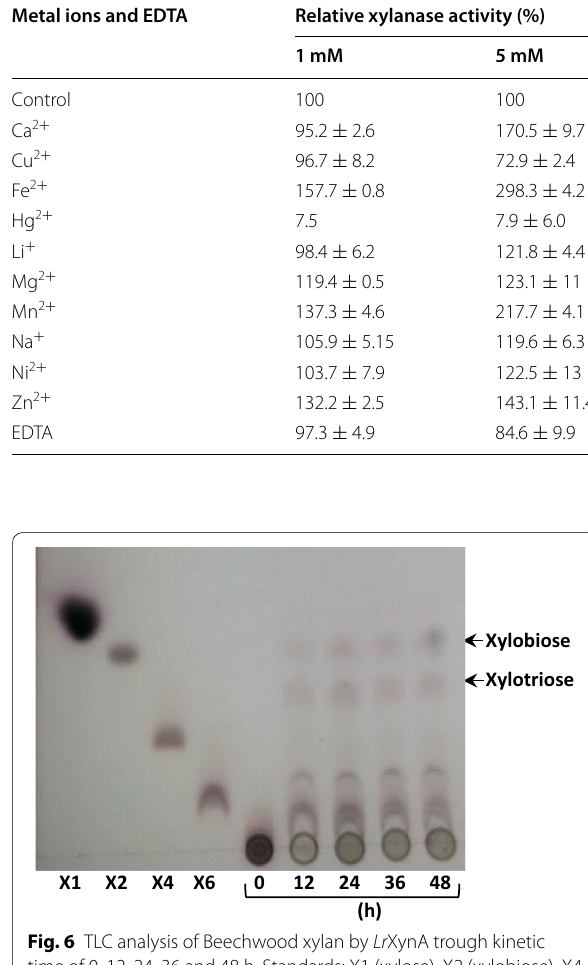
Table 4 Influence of metal ions and EDTA on the xylano- lytic of Lr XynA